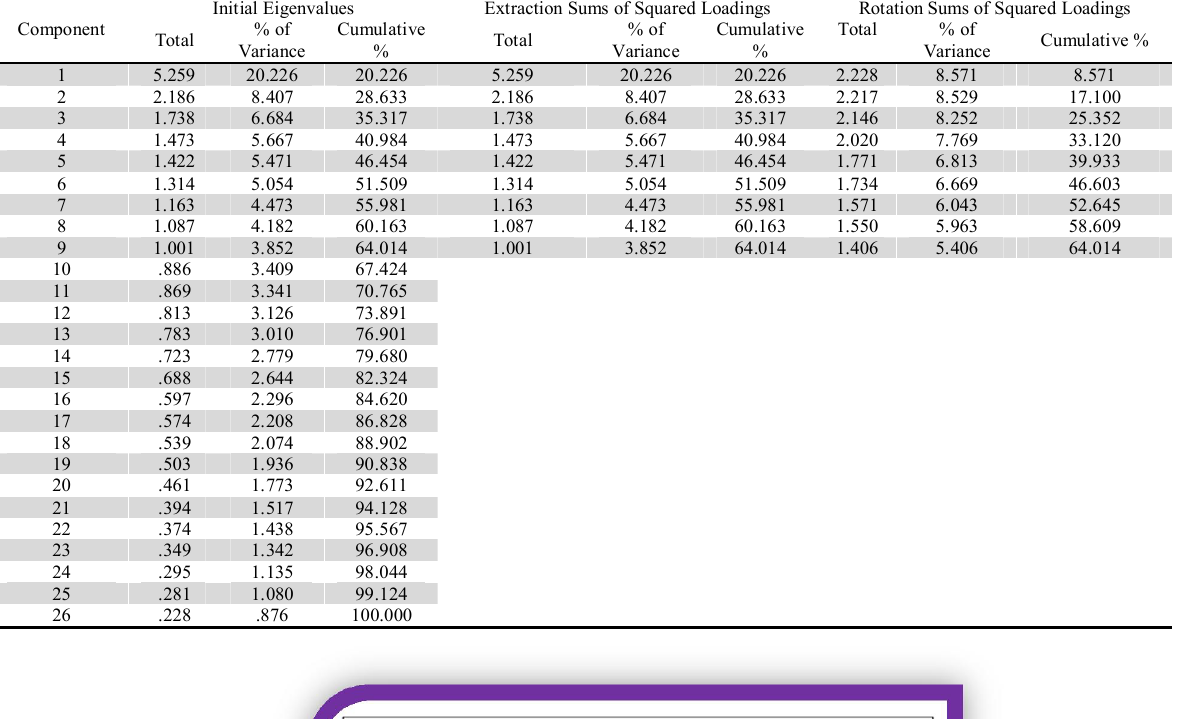
The summary of factor analysis Component